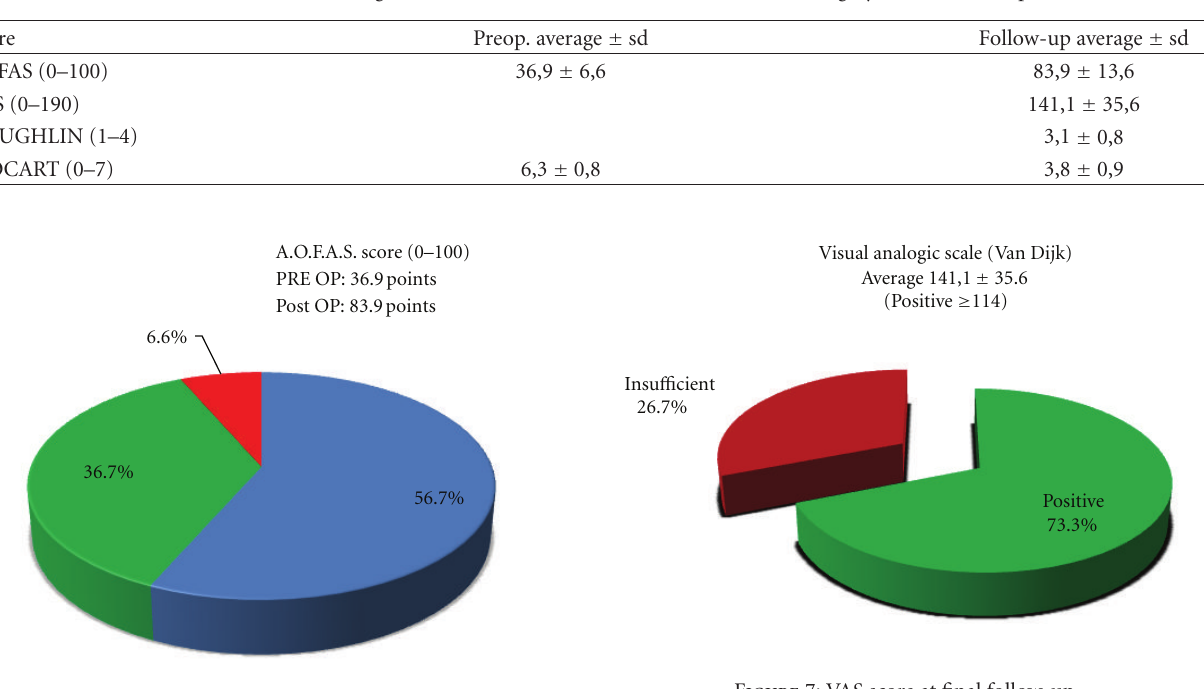
Figure 7: VAS score at final